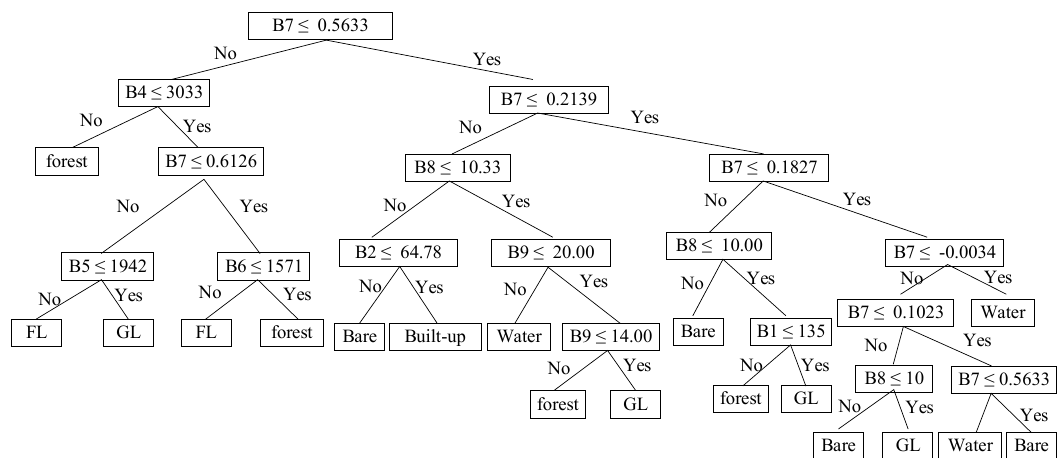
Figure 3. Decision tree classification process. Note: B1–B8 respectively correspond to the 8 bands of the composite image.